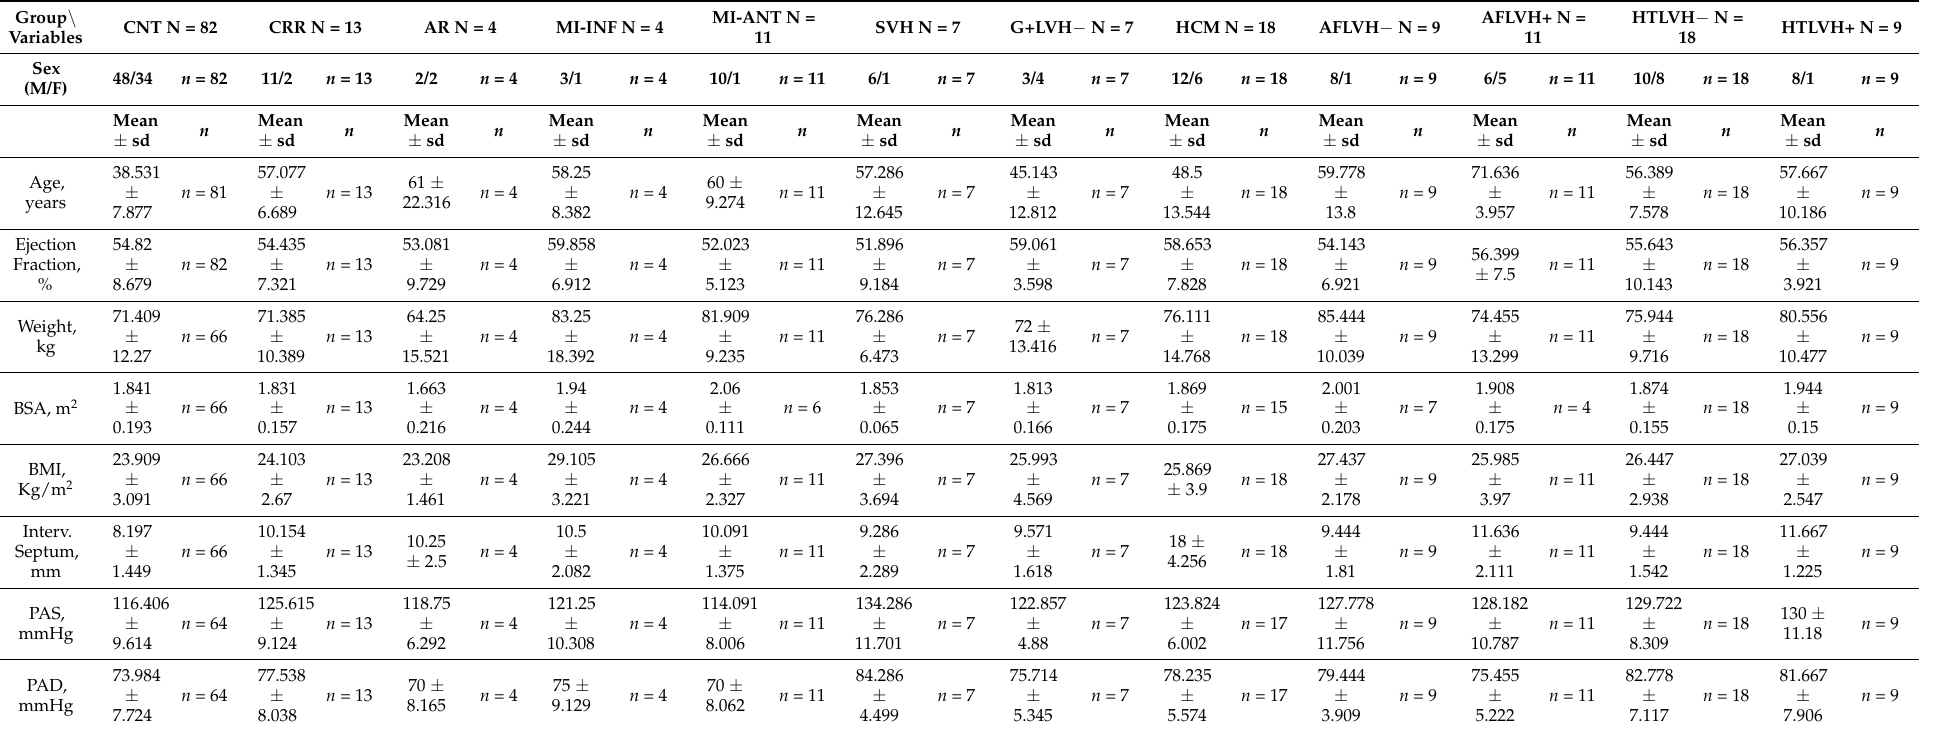
Table 2. Demographic parameters for the categories under study